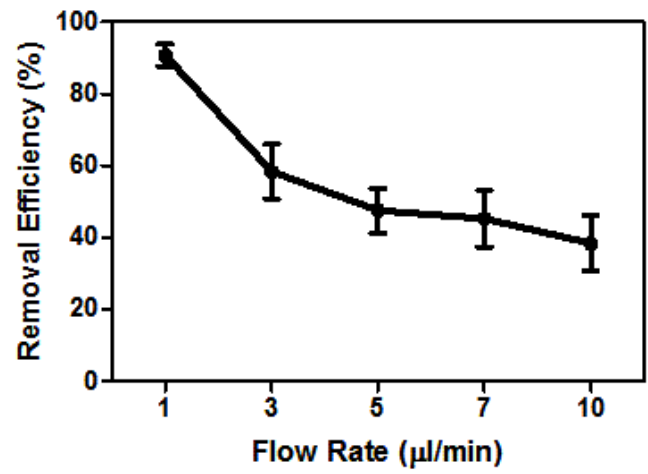
Figure 4. Separation efficiency with the flow rates. The live cells were captured at 20 Vpp, 300 kHz, while the dead cells were removed using 1, 3, 5, 7 and 10 µ L/min flow rates. For each flow rate, three independent experiments were performed, and the error bars present the standard deviations.